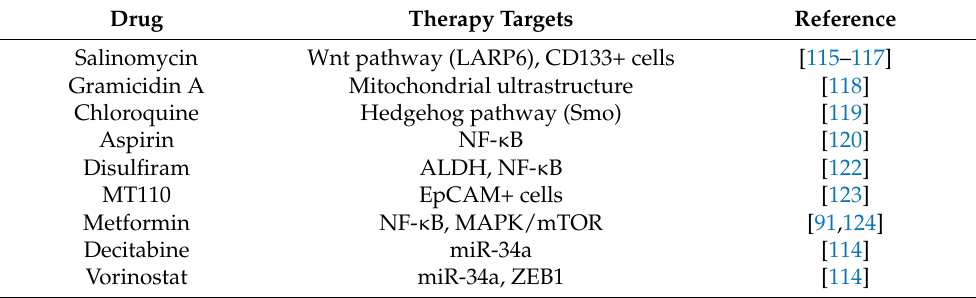
Table 1. Anti-CSC agents and the relevant therapy